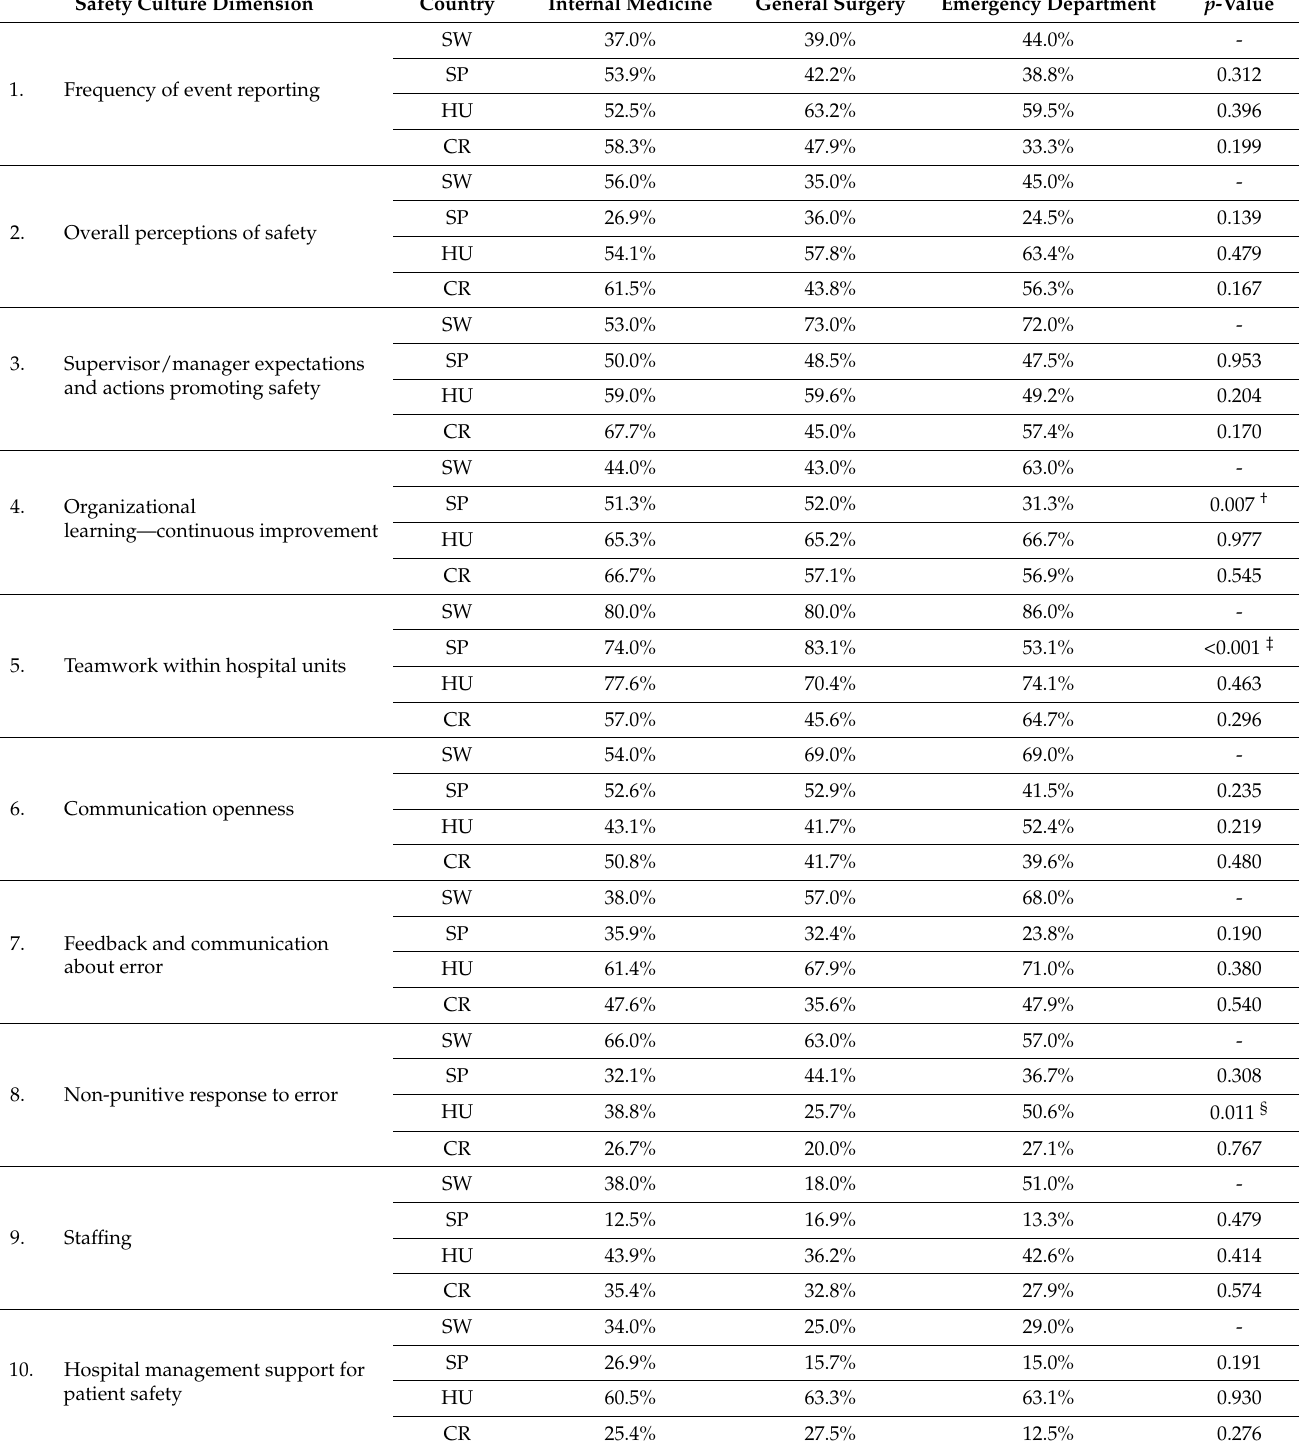
Table 2. Positive perception (%) for each dimension by unit type within